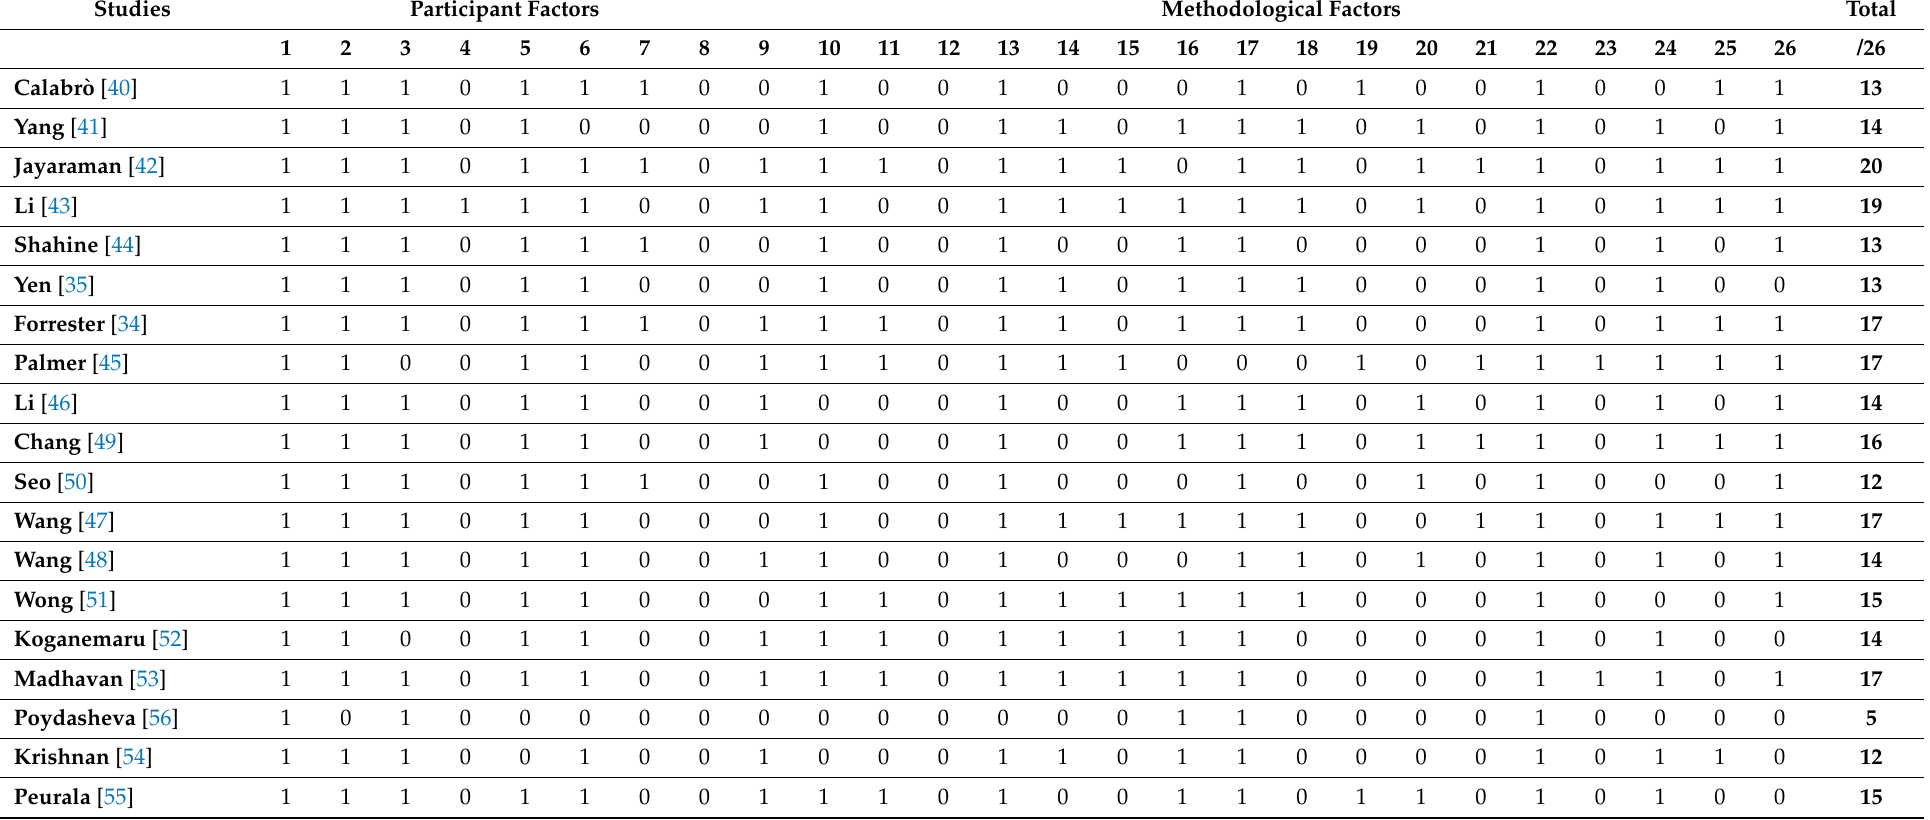
Table 2. Please TMS-specific components of methodological quality using the Chipchase